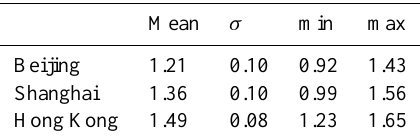
Table 1. Degrees of freedom from the surface up to the mean tropopause height averaged over the year 2008 with the associated standard deviation ( σ ), mean daily minimum (min) and mean daily maximum (max).